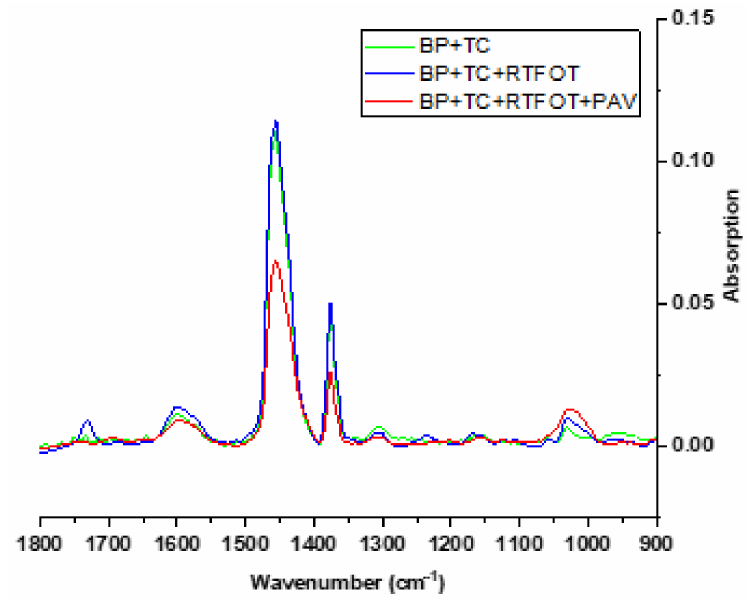
Figure 10. FTIR spectra for BP + TC at all ageing